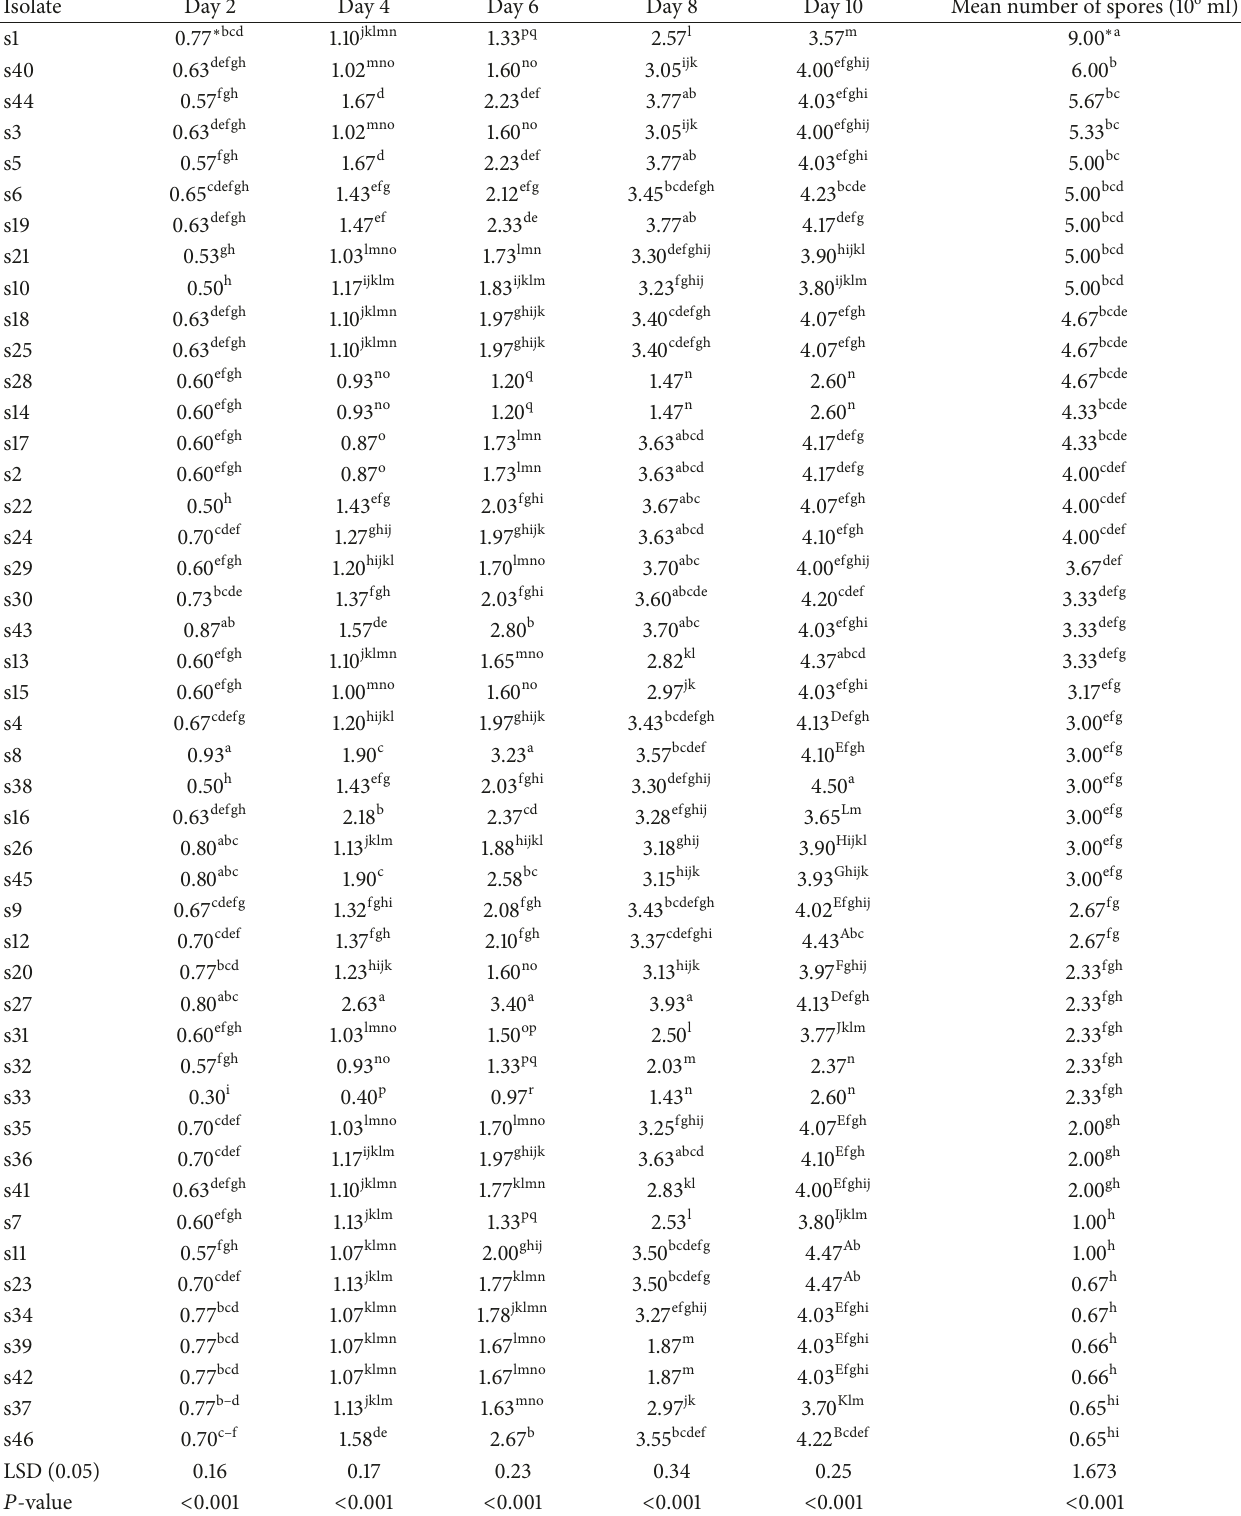
Table 2: Daily mycelial growth and mean number of spores of Colletotrichum gloeosporioides